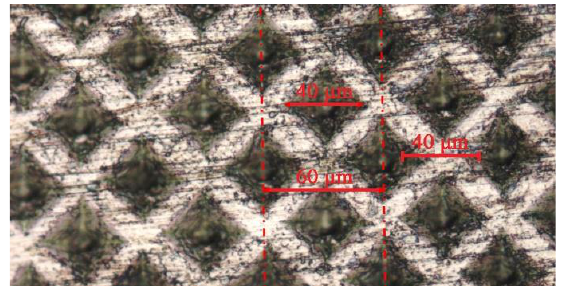
Figure 3. Type of prints on the surface of the plates after indentation.